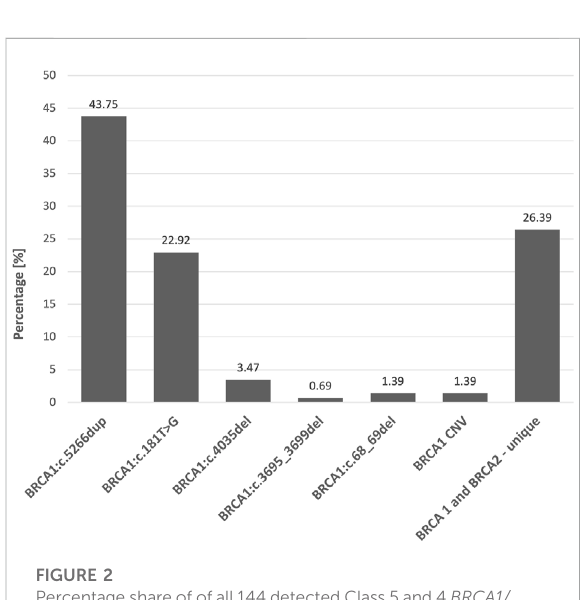
FIGURE 2 Percentage share of of all 144 detected Class 5 and 4 BRCA1/ 2